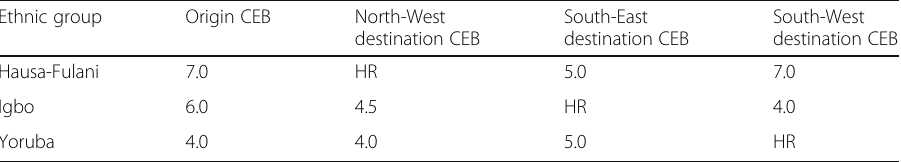
Ethnic group Origin